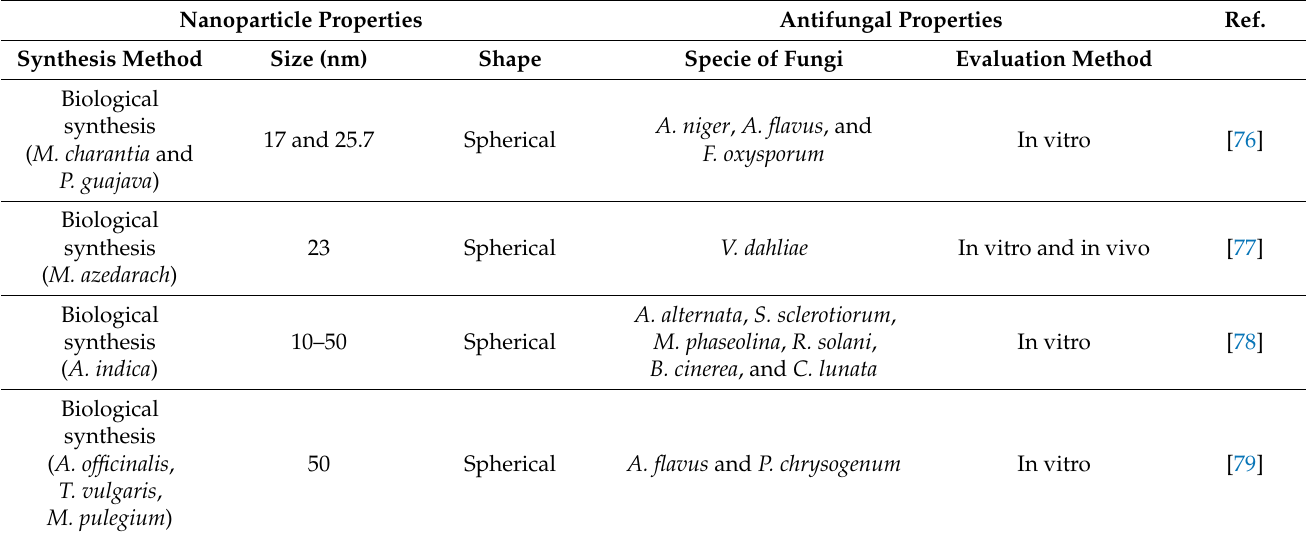
Table 1. Characteristics and antifungal evaluations of Ag nanoparticles.